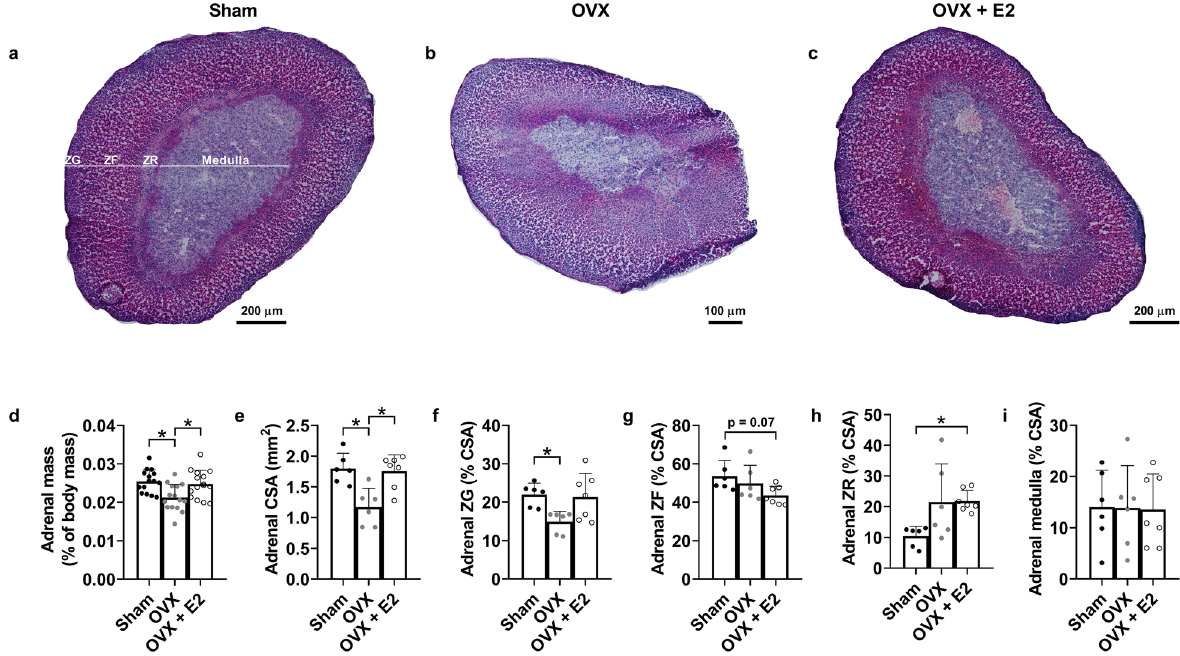
Figure 6. Ovariectomy affects adrenal gland morphology in female mdx mice. ( a ) Representative H&E cross- sectional stain of the adrenal gland in sham-operated (sham; laparotomy without removal of the ovaries), ( b ) ovariectomized OVX) and ( c ) OVX + oestradiol (E2) female mdx mice. ( d ) Adrenal mass, ( e ) adrenal cross-sectional area (CSA), ( f ) adrenal zona glomerulosa (ZG) area, ( g ) adrenal zona fasciculata (ZF) area, ( h ) adrenal zona reticularis (ZR) area and ( i ) adrenal medulla area in sham, OVX and OVX + E2 female mdx mice. N = 5–15/group. Adrenal mass, adrenal CSA, adrenal ZF and adrenal medulla were analysed by one-way ANOVA with Tukey’s post‑hoc analysis. Adrenal ZG and adrenal ZR were analysed by Kruskal–Wallis test with Dunn’s post‑hoc analysis. Data are mean ± SD. *p <